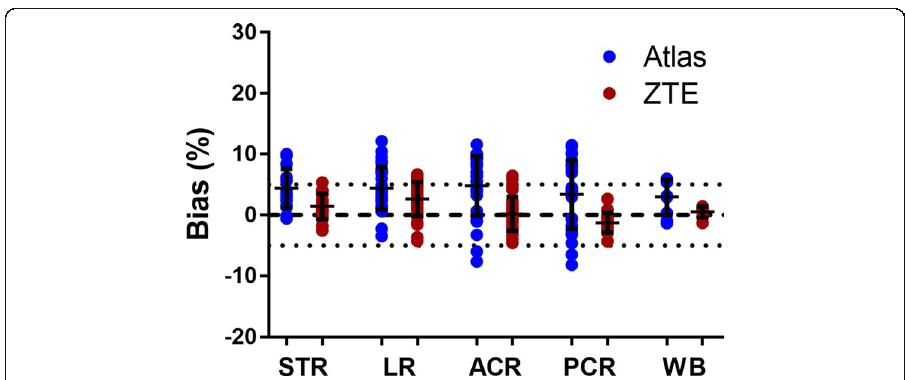
Fig. 5 Relative bias in SUVR after use of ZTE- or atlas-attenuation correction (AC) compared to 68 Ge-AC for different regions of interest. STR, striatum; LR, limbic regions; ACR, anterior cortical regions; PCR, posterior cortical regions; WB, whole-brain. Bars and whiskers are mean ±